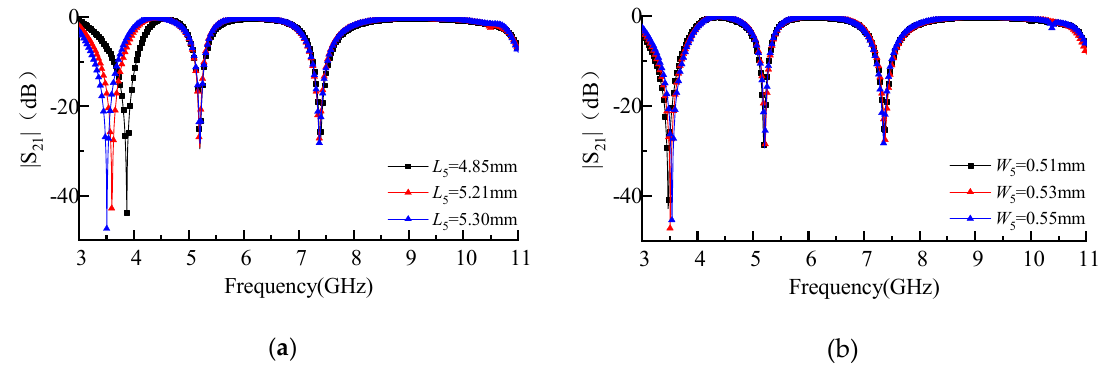
Figure 15. ( a ) Simulation results with di ff erent L 5 ( L 5 = 4.85 mm, f 1 = 3.87 GHz, L 5 = 5.21 mm, f 1 = 3.6 GHz, L 5 = 5.3 mm, f 1 = 3.51 GHz); ( b ) simulation results with di ff erent W 5 ( W 5 = 0.51 mm, f 1 = 3.47 GHz, W 5 = 0.51 mm, f 1 = 3.5 GHz, W 5 = 0.55 mm, f 1 = 3.54 GHz).